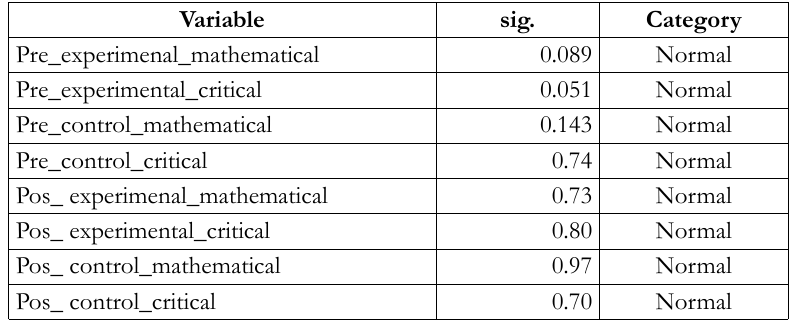
Table 13. Result of normality test